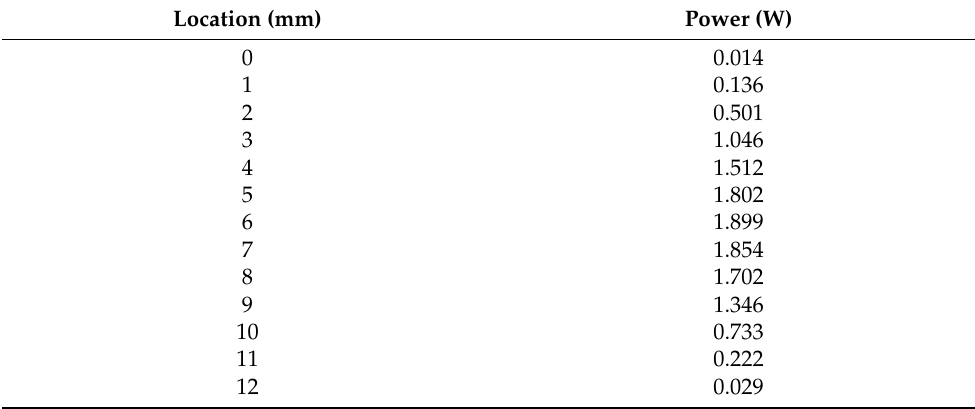
Table 1. Laser power distribution intensity on the